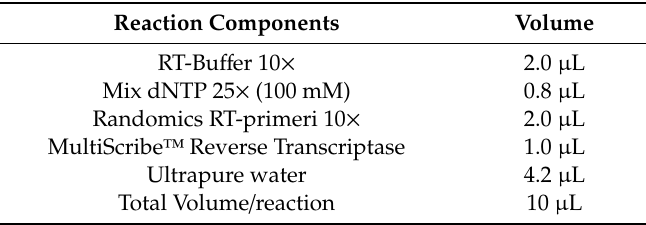
Table 1. Preparation of the reaction mixture /